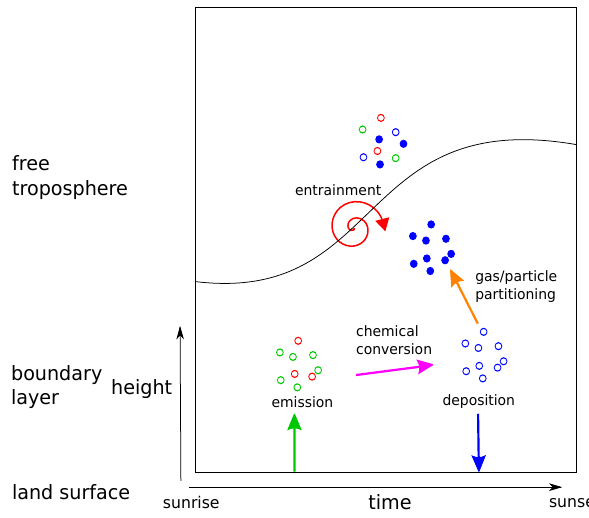
Figure 3. Processes relevant to evolution of species concentrations in the boundary layer. Open and closed circles depict gas-phase and aerosol-phase species,